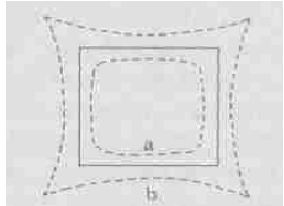
Figure 2 Distortion model of the camera